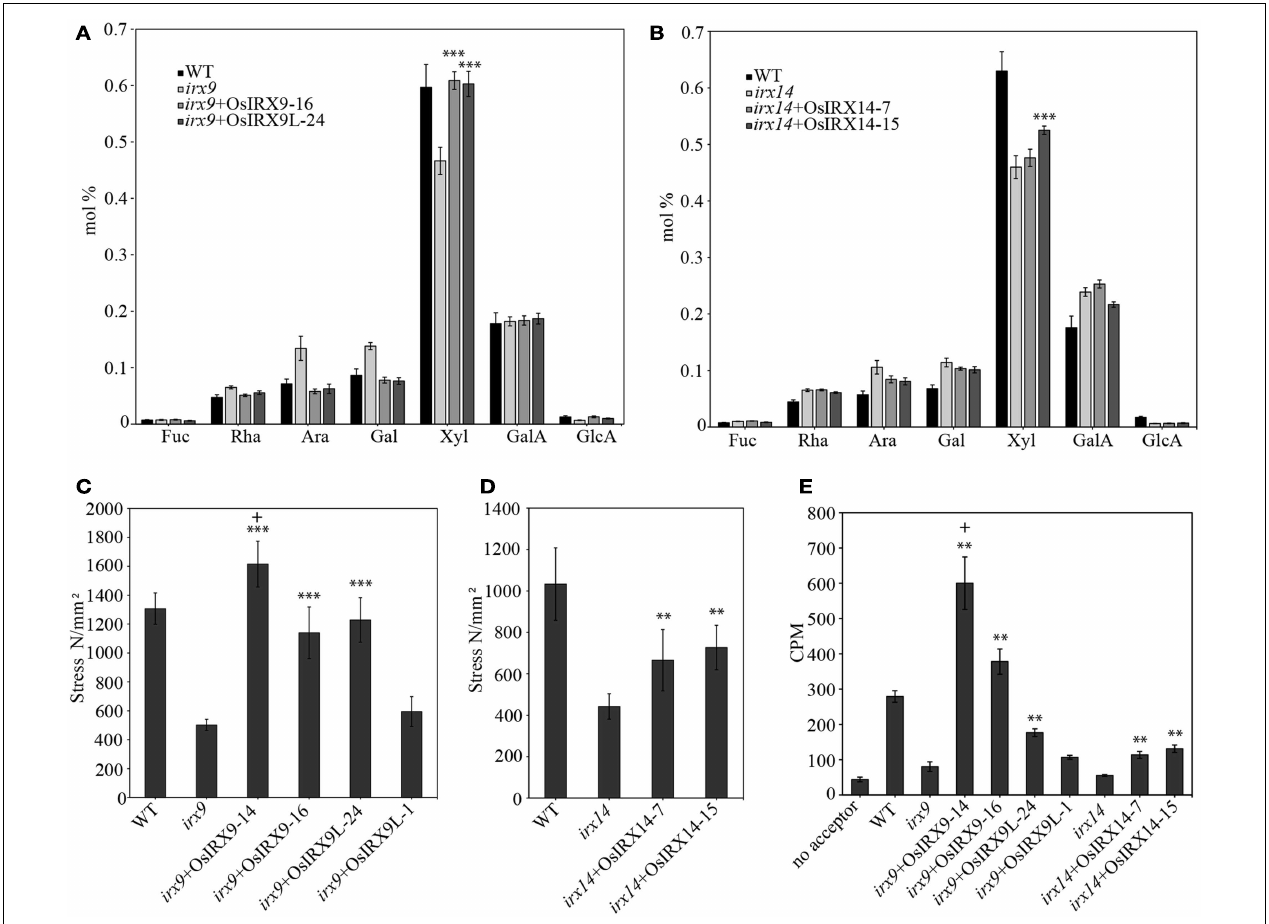
OsIRX14 genes. Error bars represent SD with at least eight biological replicates. (E) Restoration in xylosyltransferase activity of irx9 and irx14 mutant plants by over-expression of rice genes.The two OsIRX9 lines had xylosyltransferase activity that exceeded that of wild type. Error bars represent SD with three biological replicates. Key: significantly different from respective mutant background by t test * p < 0.05, ** p < 0.01, *** p < 0.001; significantly different fromWT by t test: + p <